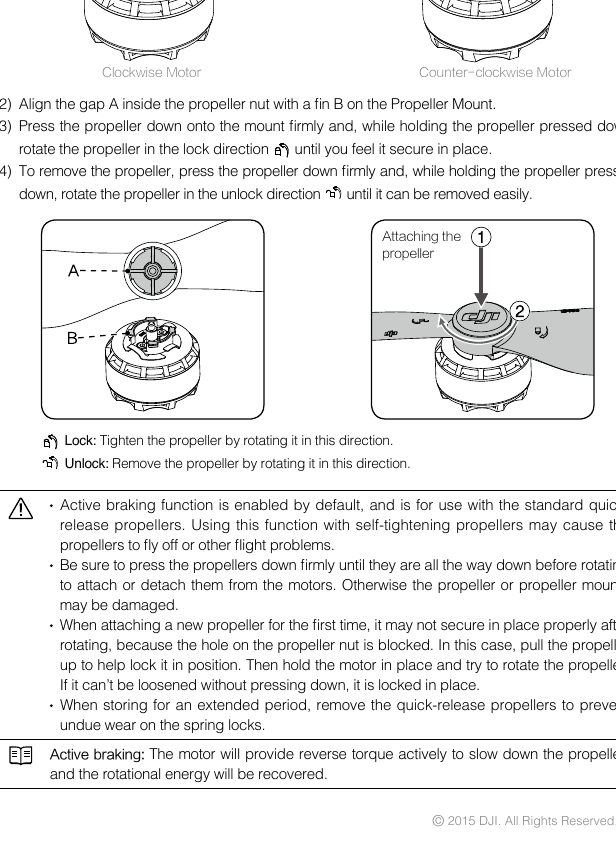
Securing Spring